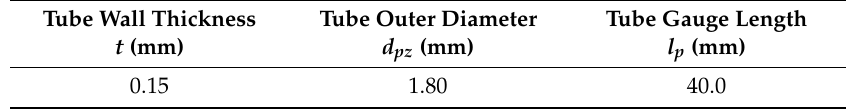
Table 5. Model specimen dimensions in numerical longitudinal tensile tests (Figures 2 and 5).